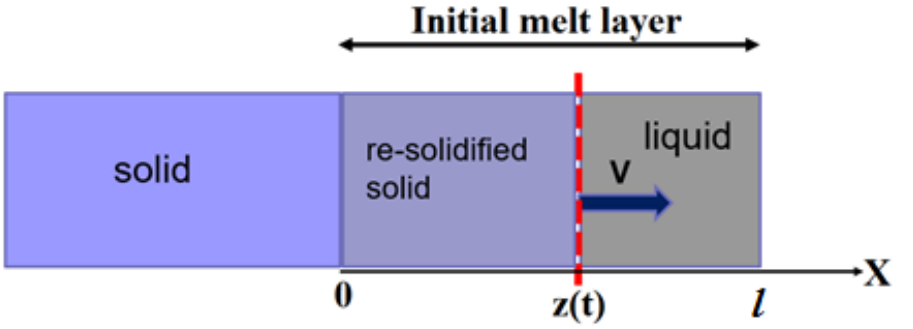
Figure 1. Schematic of an advancing solid – liquid interface during re-solidification of a thin metal layer after ultrashort pulse laser melting. l — is the initial thickness of the melted layer. Liquid phase ( liq ) is depicted at x > z ( t ) and solid phase ( sol ) is depicted at x < z ( t